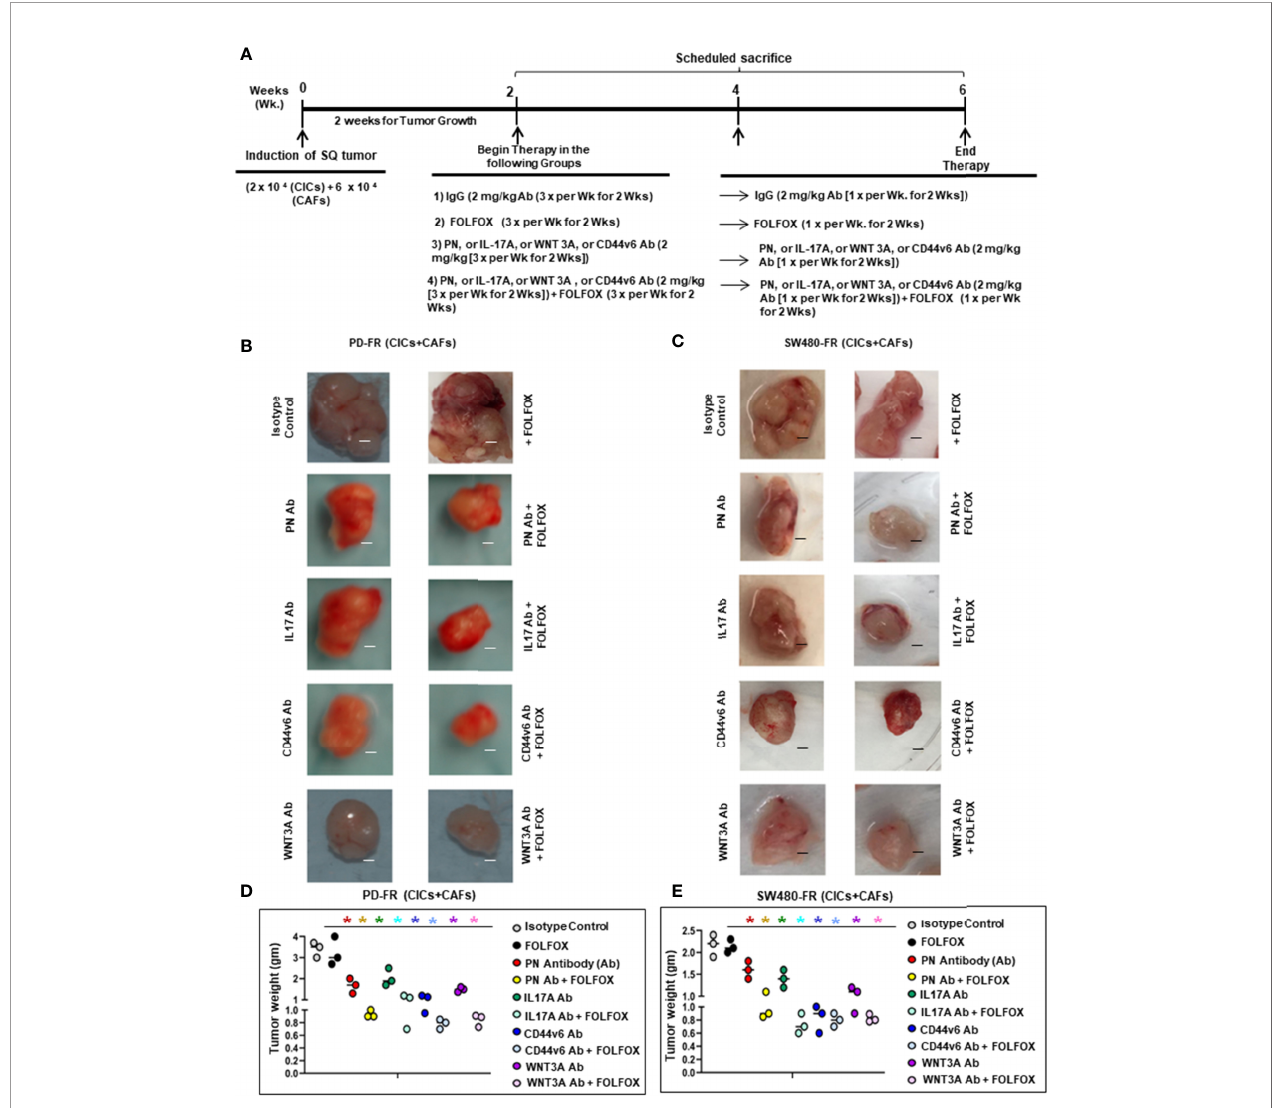
( Figure 7D ) showed robust binding of b -catenin/TCF4 to MDR1 sites in the SW480-FR cells. Results also showed a robust binding activity for CD44v6 to the DNA fragment where TCF4 binds ( Figure 7D ). Knockdown of CD44v6 reduced endogenous b - catenin/TCF4 binding to the MDR1 promoter in response to PN and IL17A in SW480-FR cells ( Figure 7D ), thus validating the results from the luciferase reporter assay ( Figure 7B ) that CD44v6